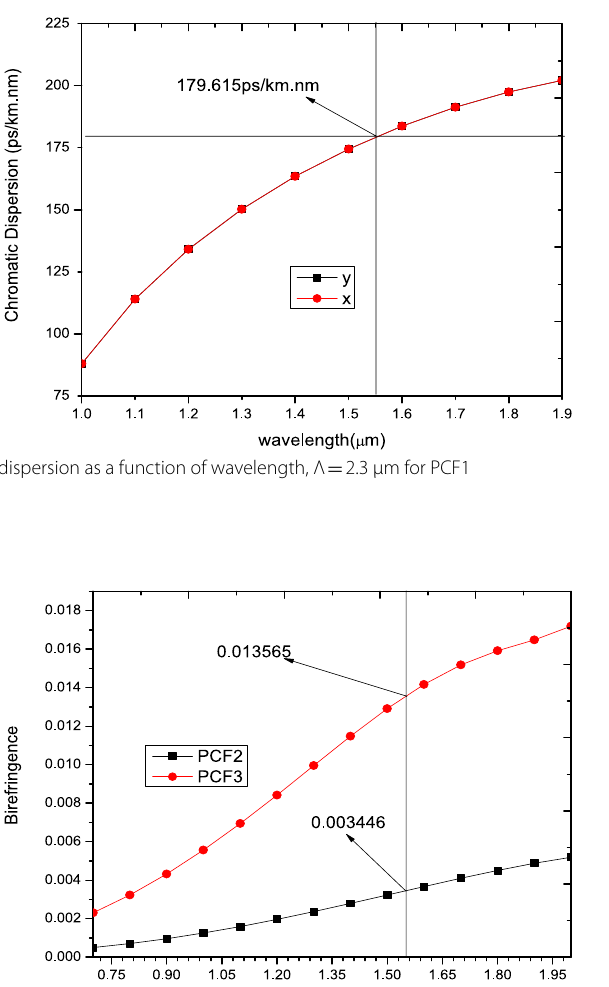
Fig. 9 Variation of Birefringence as a function of wavelength for PCF2 and